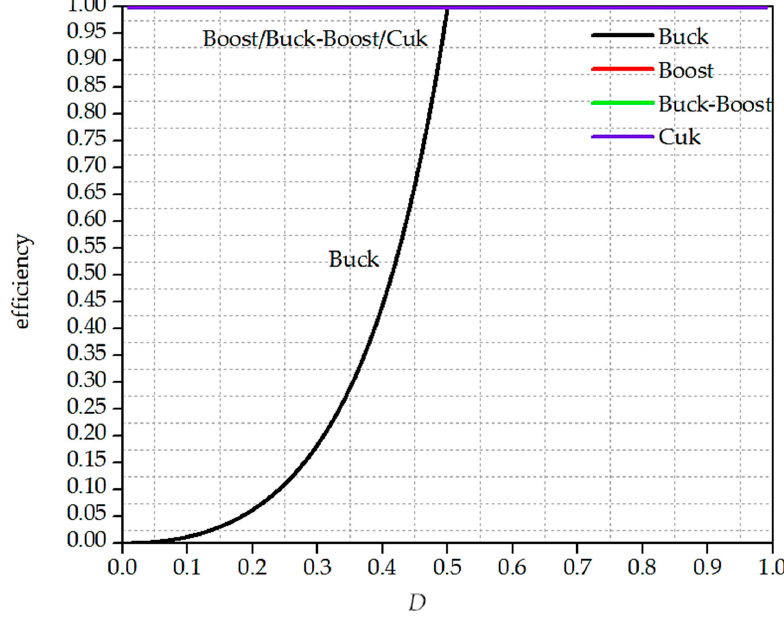
Figure 12. Relationship between efficiency and D of the LED in transistor converter.